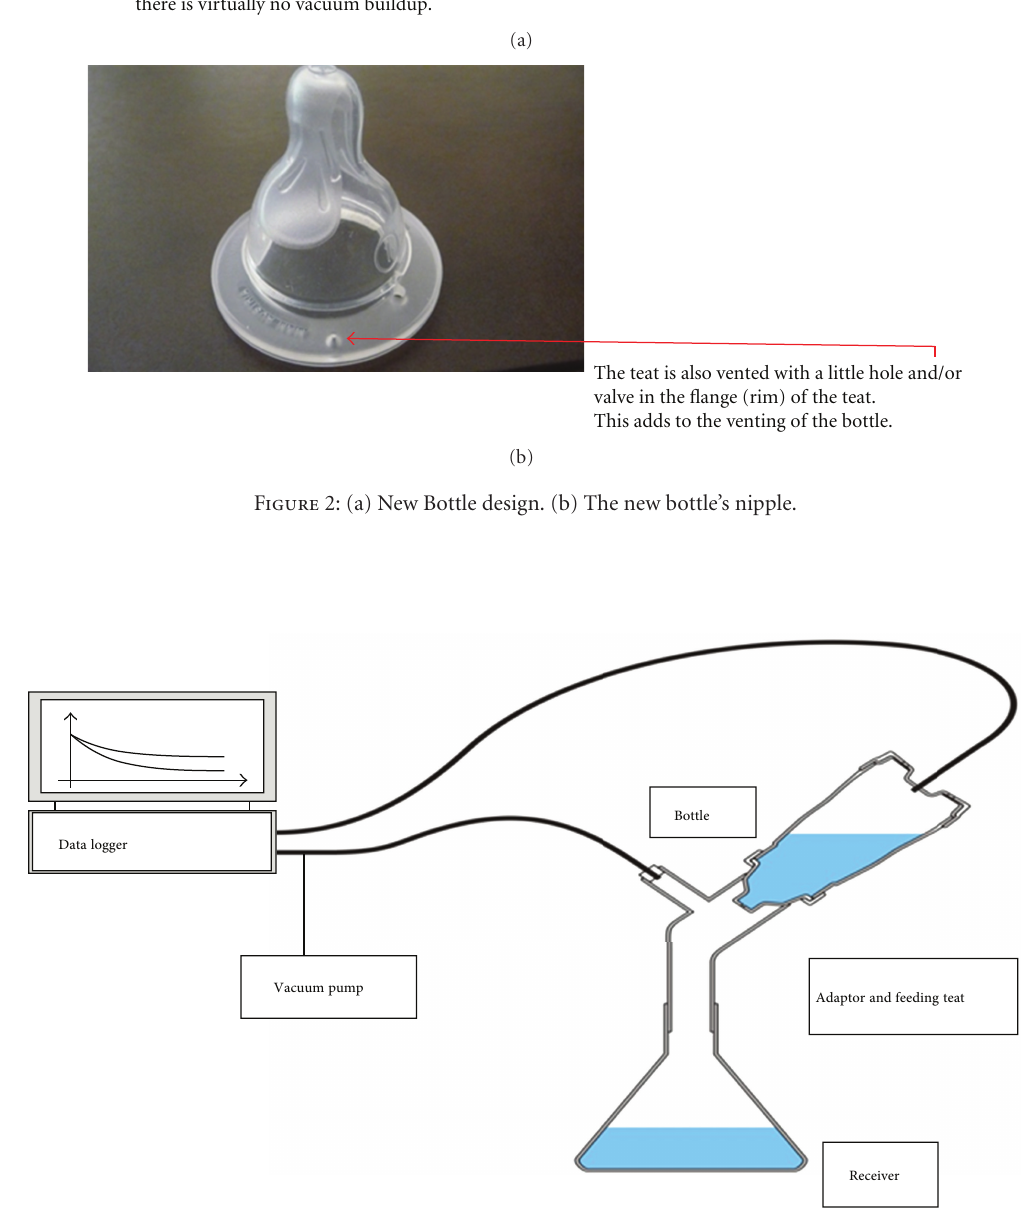
Figure 3: Schematic view of the bottle testing